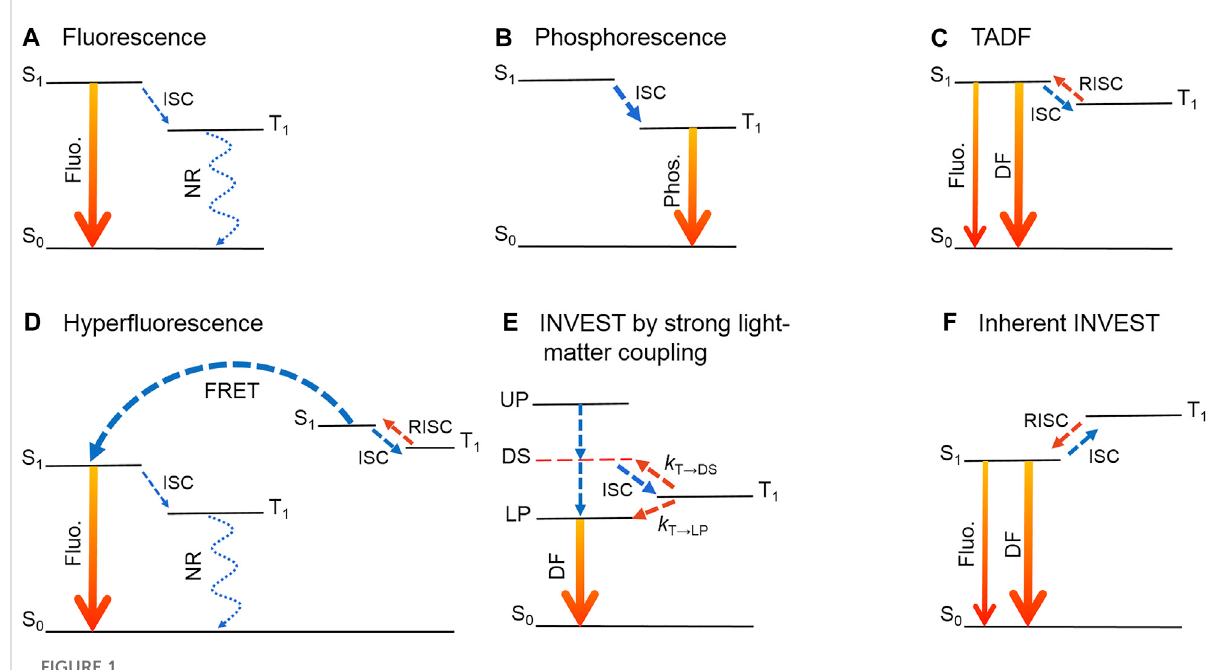
FIGURE 1 Luminescence mechanisms of organic light-emitting materials. (A) Fluorescence. (B) Phosphorescence. (C) Thermally activated delayed fl uorescence (TADF). (D) Hyper fl uorescence. (E) INVEST by strong light-matter coupling. (F) Inherent INVEST. Fluo., fl uorescence; Phos., phosphorescence;DF,delayed fl uorescence;ISC,intersystemcrossing;RISC,reverseintersystemcrossing;FRET,Försterresonanceenergytransfer; UP, upper polaritons; DS, dark singlet states; LP, lower polaritons; NR, nonradiative decay. k T → DS and k T → LP : RISC rate constants from T 1 to DS and from